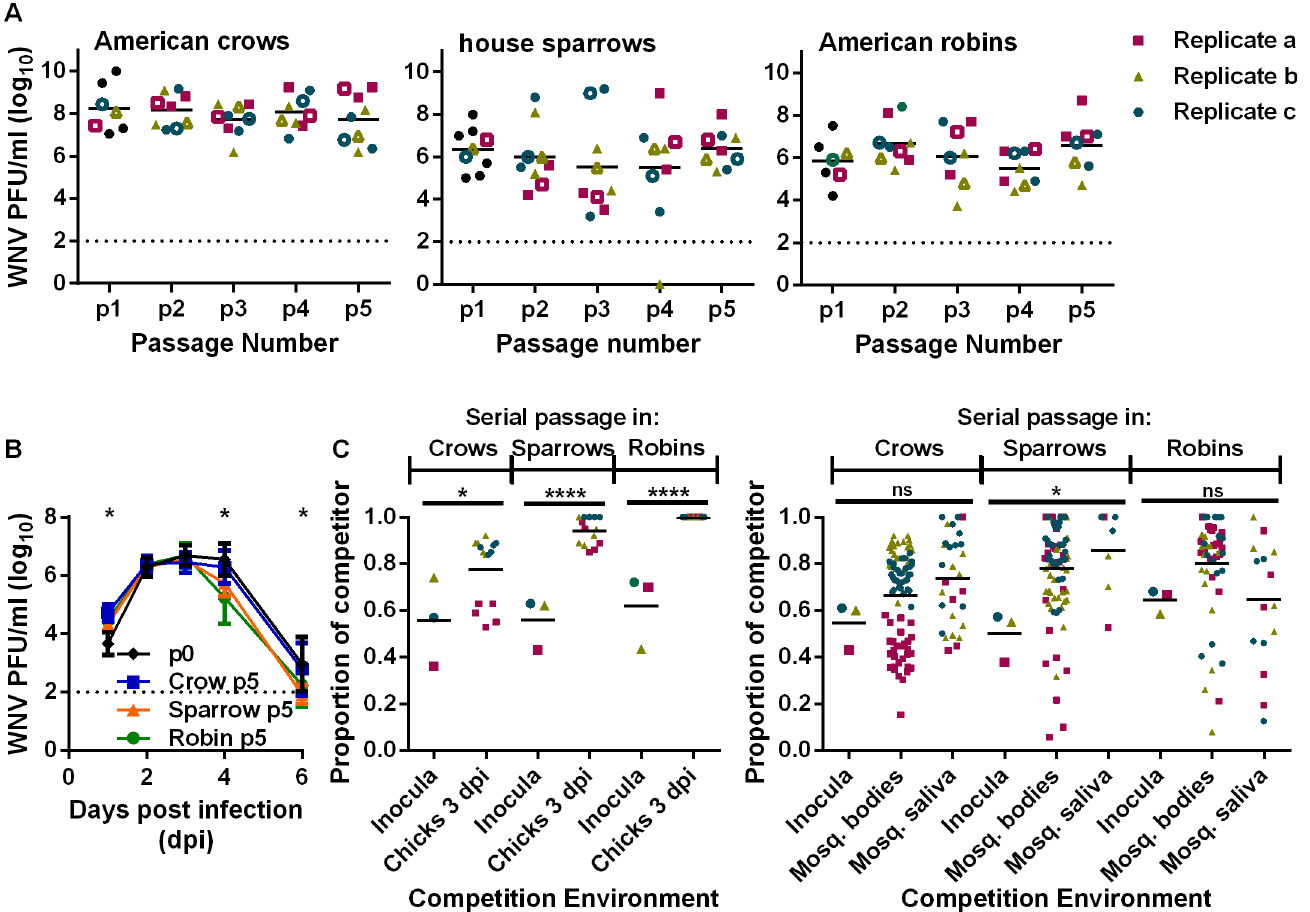
Fig 1. Passage of WNV in birds results in competitive fitness increases while viremia remains unchanged. ( A ) WNV titers during passage. Open symbols represent samples with median viremias that were used for subsequent passage. ( B ) Viremia production after sequential passage, measured in young chickens (mean ± SD, n = 12 – 15 chickens each, data from passage replicates combined, * , P < 0.01,two-way ANOVA with Tukey ’ s correction). Dashed lines indicate the assay detection limits. ( C ) Competitive replicative fitness in young chickens (left; * , P = 0.0339; **** , P < 0.0001, unpaired t-test) and mosquitoes (right; ns, not significant; * , P < 0.05, unpaired t-test for both bodies and saliva). Passage replicates are colored as in (A) and horizontal lines represent the mean proportion of bird-passed WNV. Phenotypic assessment of wild bird passaged virus in its passaged host and in orally infected mosquitoes are in S1